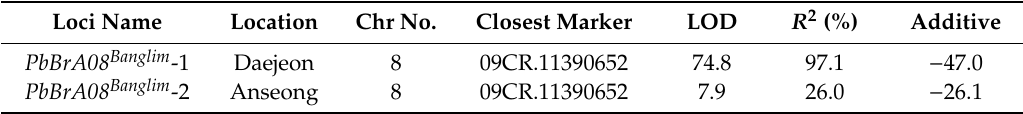
Table 2. Summary of QTLs detected for clubroot resistance against the Banglim pathotype of P . brassicae using composite interval mapping (CIM). LOD—logarithm of